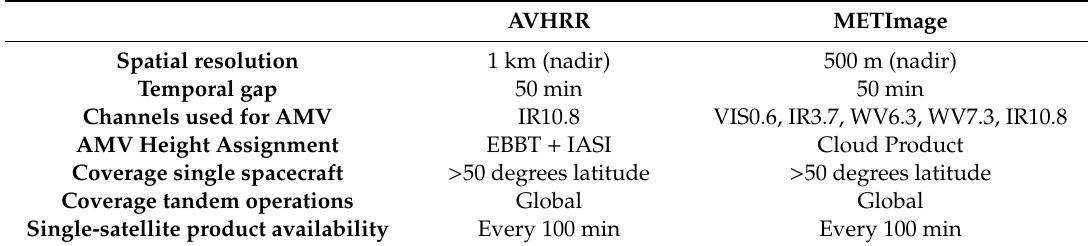
Di ff erences between EPS / AVHRR and EUMETSAT Polar System-Second Generation (EPS-SG)-METImage AMV products